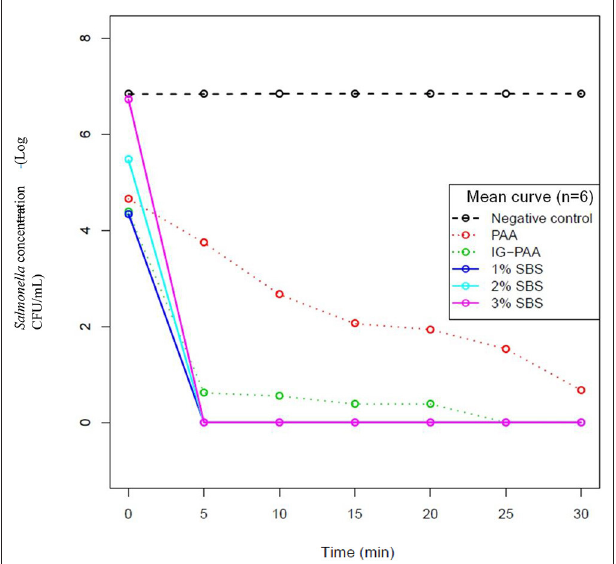
FIGURE 1 | Salmonella Typhimurium killing assay over time in each treatment. S. Typhimurium inoculated microcosms with five acidifier treatments were immediately plated onto XLD ( n = 6). Every 5min after that for 30min, plating occurred, and log-transformed counts were graphed. A value of 0.1 log CFU/mL was applied to visualize overlapping data points. Data points at zero were below the limit of detection (10 CFU/mL). The solid blue, cyan, and magenta line represents 1, 2, and 3% SBS treatments. The dashed red and green lines represent 200 ppm PAA and 200 ppm IG-PAA, respectively. The black dashed line represents the no treatment negative